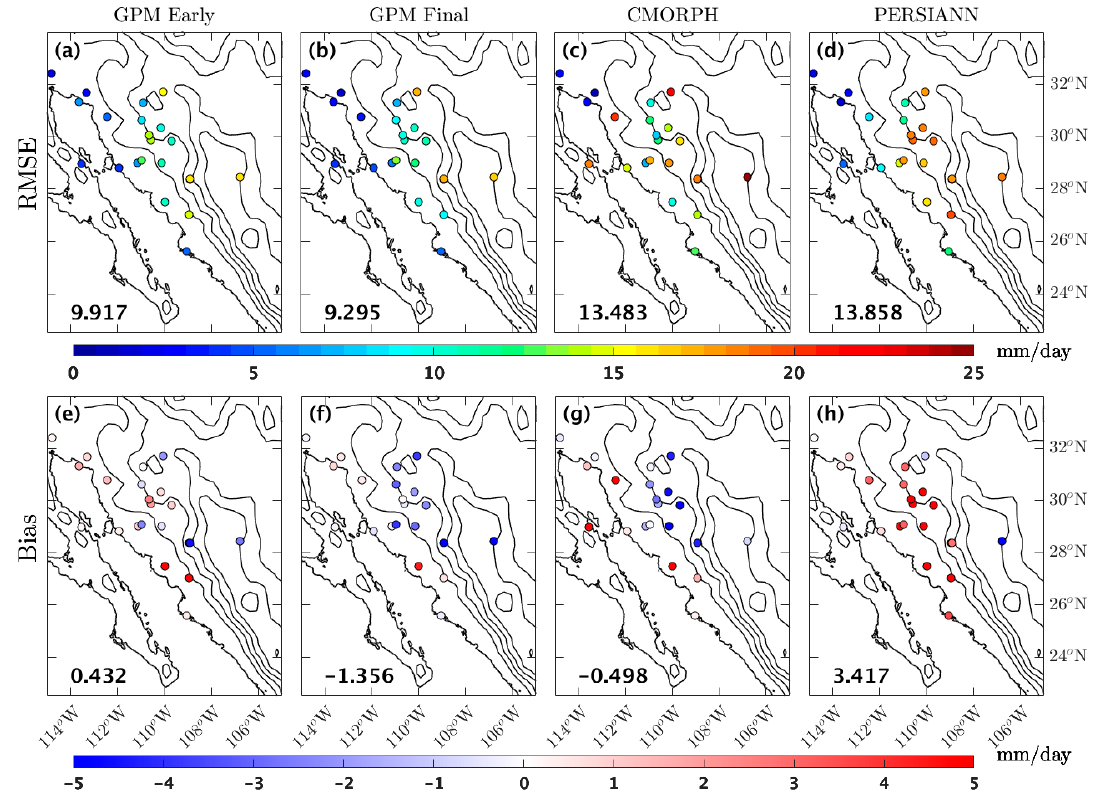
Figure 2. Root mean square error (RMSE) and bias between the daily rain gauge measurements at the observation sites and the satellite-based daily precipitation measurement from 30 June to 12 September. Bias is calculated as satellite measurement minus rain gauge measurement. The value at the bottom left of panel ( a – d ) is the mean RMSE, and the value at the bottom left of panel ( e – h ) is the mean bias. Global precipitation measurement (GPM) Final has the lowest RMSE value; GPM Early has the lowest bias. Terrain is contoured every 500 m (black